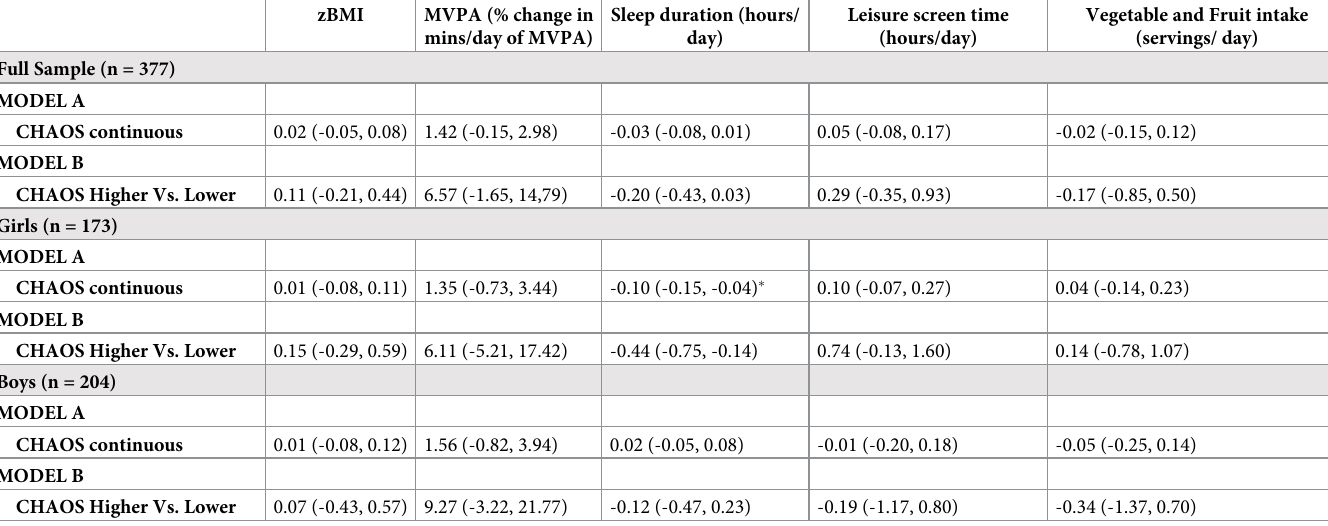
Table 2. Associations (Beta, 95% CI) between household chaos, lifestyle behaviours and zBMI, in the full sample and stratified by sex, QUALITY cohort study, visit 3 (n =